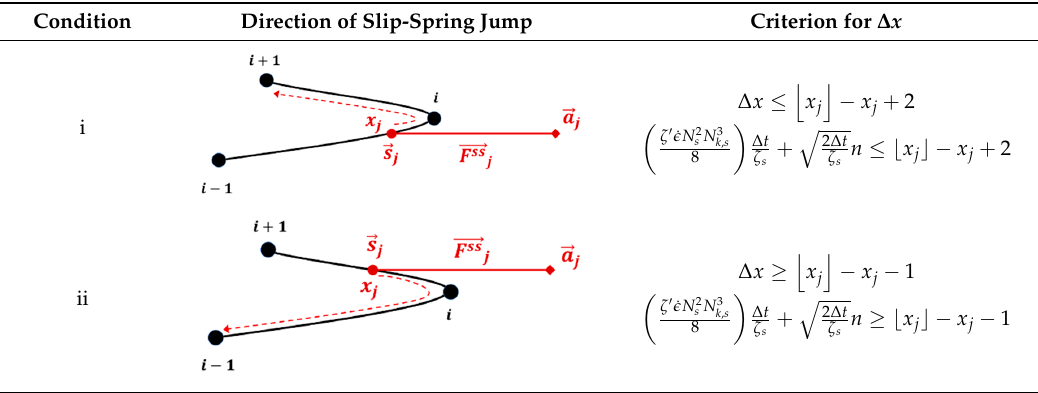
Table A1. Criteria for maximum ∆ x and corresponding times step ∆ t for two locations of slip-link in the kinked region.